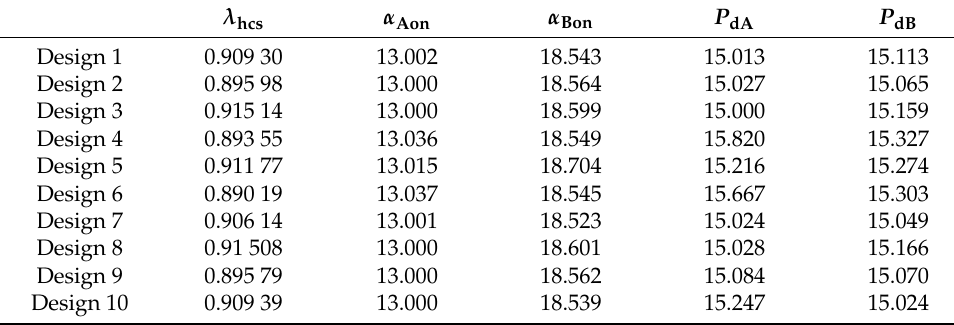
Figure 7. Pareto front when population sizes are ( a ) 200 and ( b ) 10, respectively. Table 3. Optimal results of Pareto